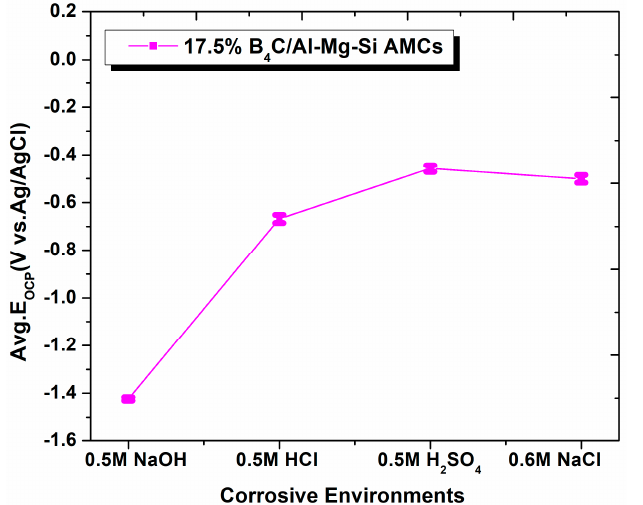
Figure 3. Variations of Average OCP with respect to corrosive environment of 17.5%B 4 C/Al-Mg-Si AMCs.